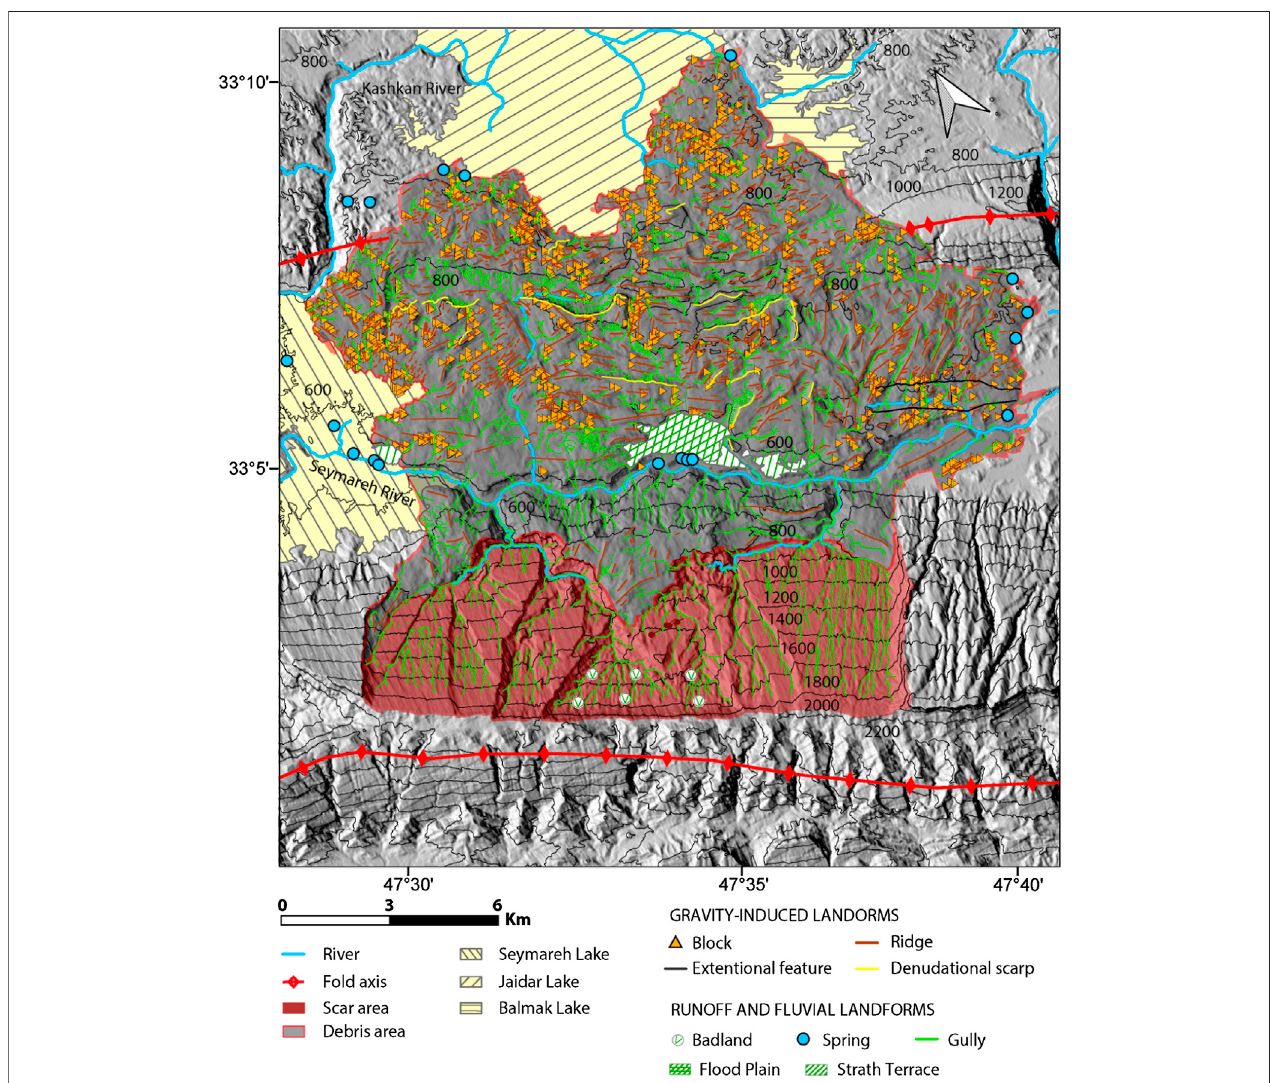
FIGURE 2 | Geomorphological map of the Seymareh landslide debris. The coordinate reference system is WGS84.